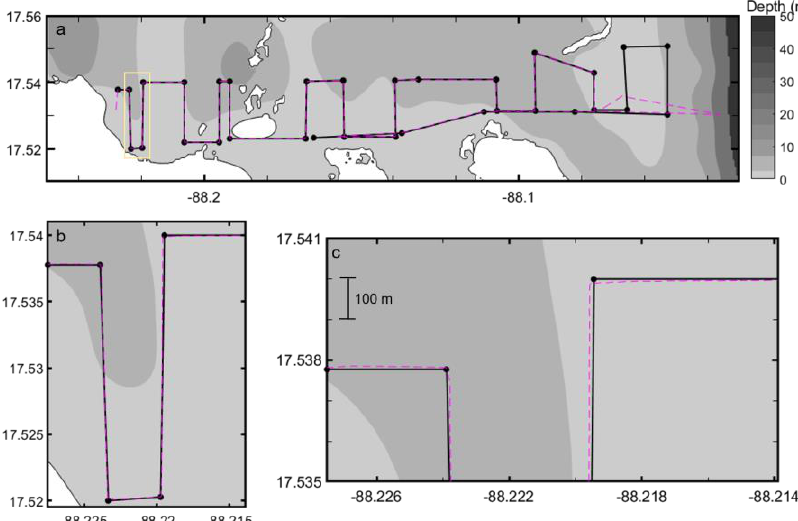
Figure 4. Testing of CW4 track following ability and line holding along Transect 1. Zoomed in section in ( b , c ) is shown in ( a ) by yellow box. The black line is planned transect marked with waypoints, which creates the lines, and the overlaid pink dashed line is track CW4 completed.